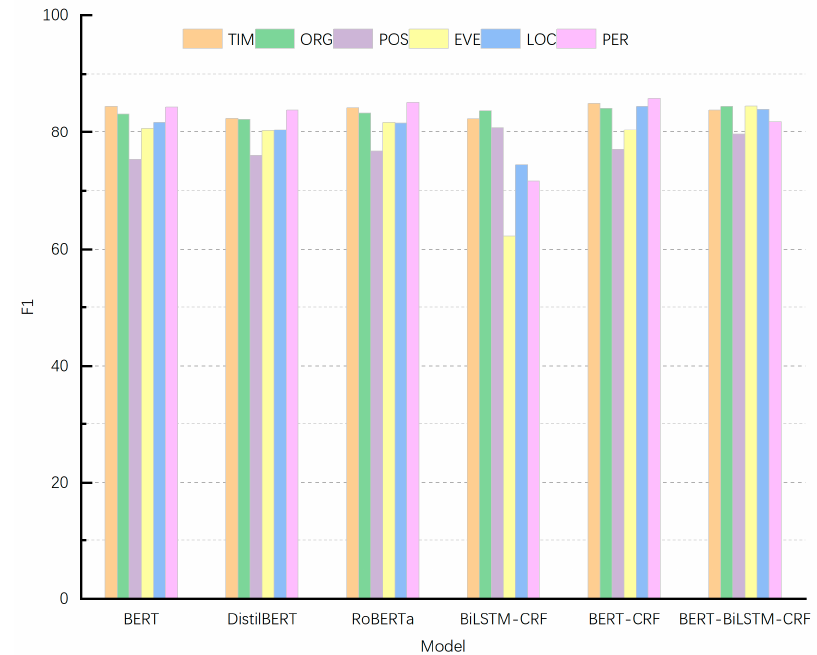
Figure 5. F1 scores of six types of entities on six models.